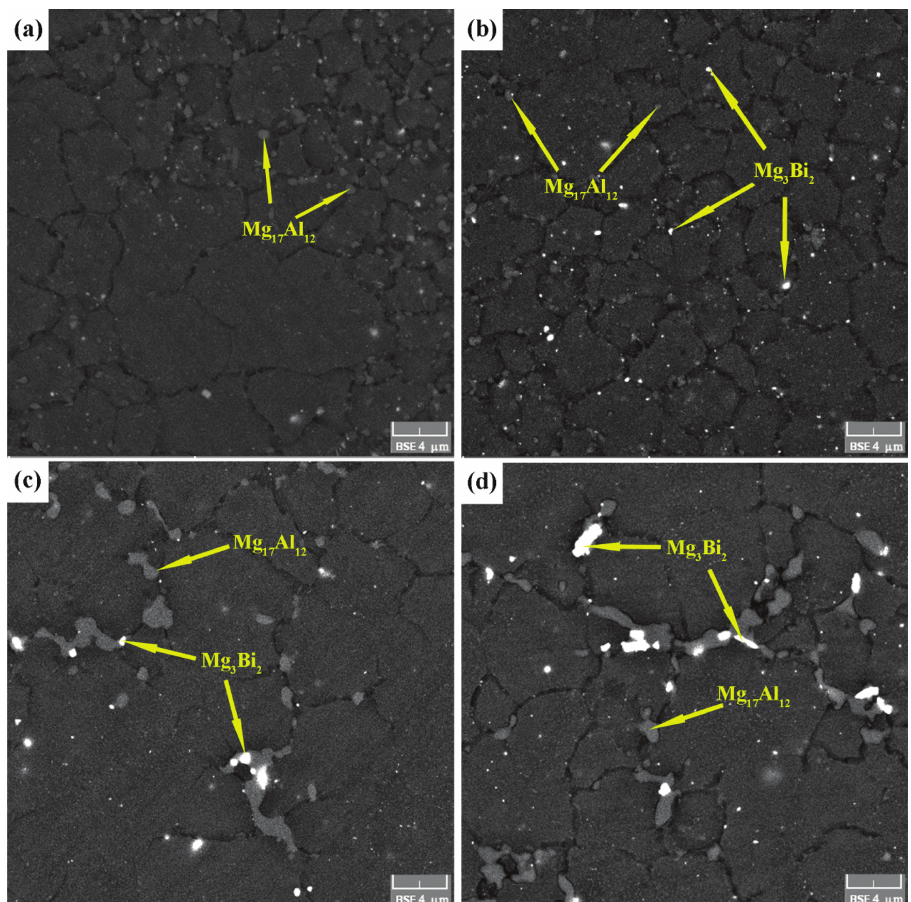
Figure 5: SEM back scattered electron images of the as-extruded AZ80 – 2Sn alloys with different Bi additions: (a) 0 mass %Bi; (b) 0.5 mass %Bi; (c) 1 mass %Bi; (d) 1.5 mass